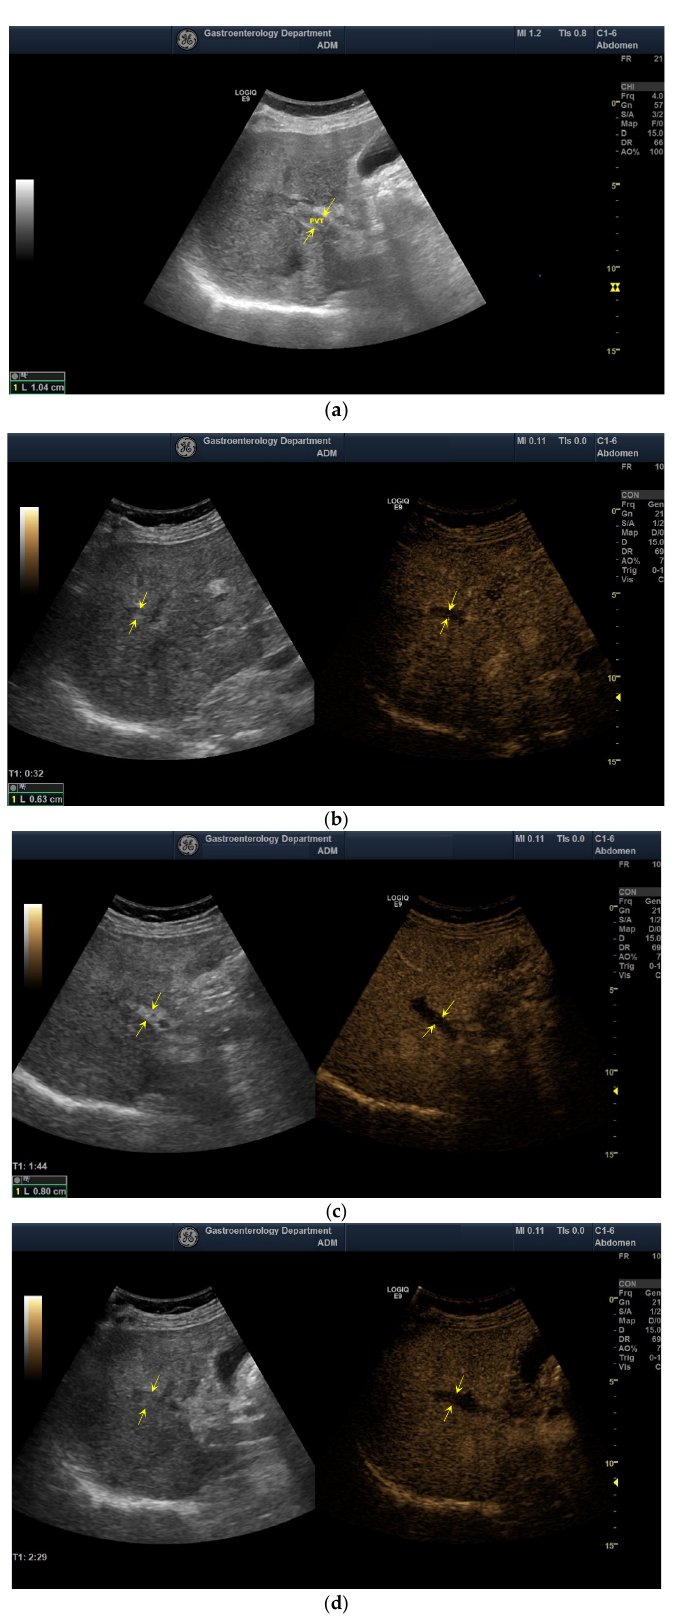
Figure 1. Ultrasound and CEUS aspect of benign PVT: ( a ) aspect in the standard US (between arrows); ( b ) no enhancement in the arterial phase (between arrows); ( c ) no enhancement in the portal phase (between arrows); ( d ) no enhancement in the late phase (between arrows).